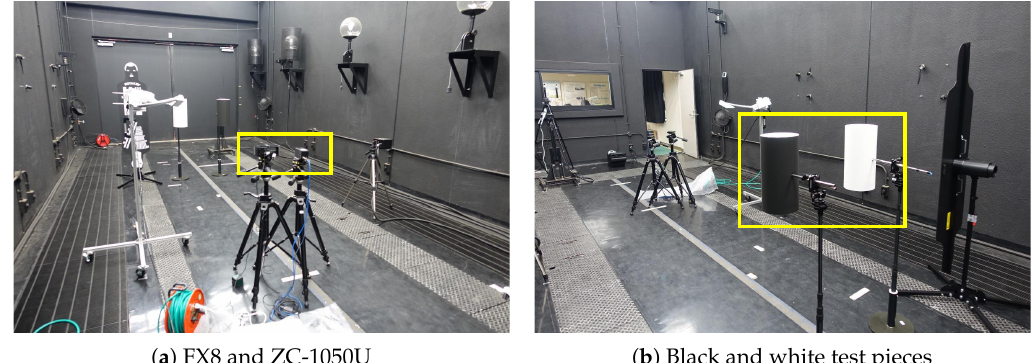
Figure 12. Experiment configuration for ESPE in the fog chamber.